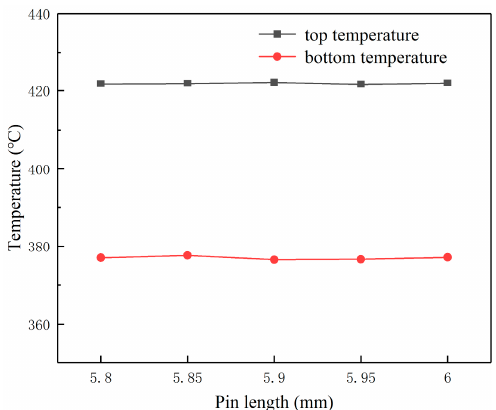
Figure 13. Influence of pin length on temperature field of the top and bottom surface of the weld (1000 rpm, 120 mm/min).